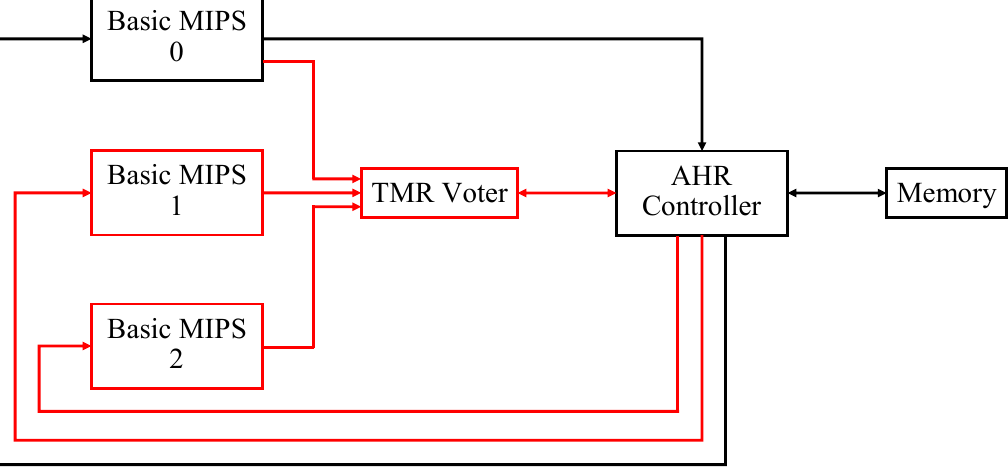
Figure 5. AHR MIPS in TSR mode simplified block diagram with disabled portions in